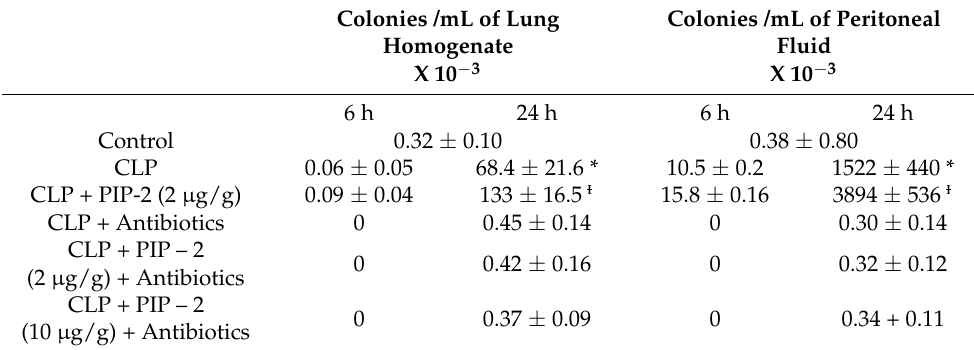
Table 3. Bacterial colony formation at 6 h and 24 h after